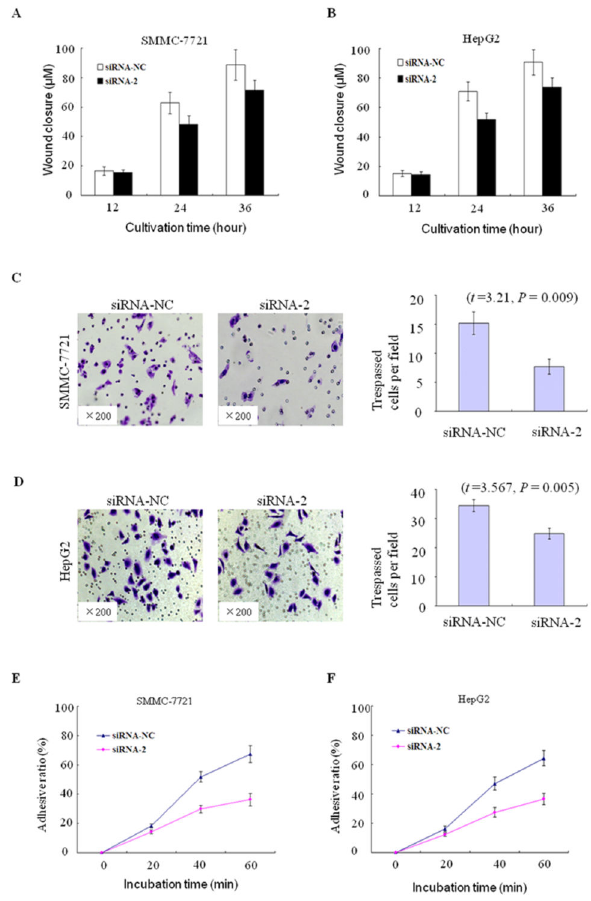
Figure 5. Effect of DLGAP5 on HCC cell